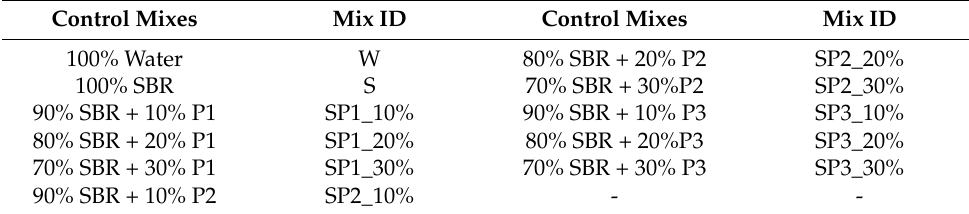
Table 3. Mixing proportions of copolymer